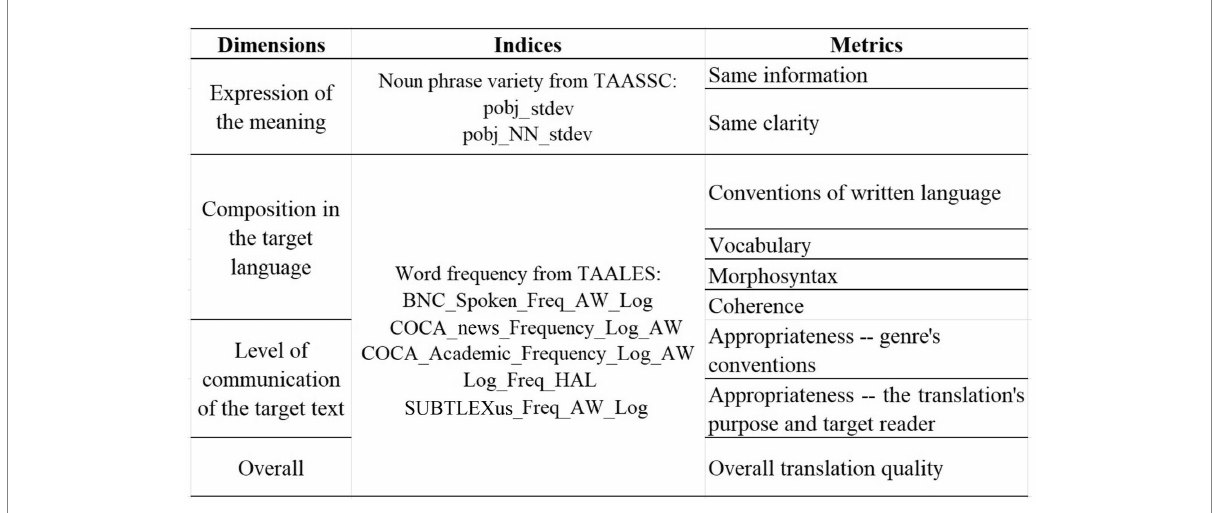
FIGURE 6 The NLP-assisted Evaluation Framework for TQA.